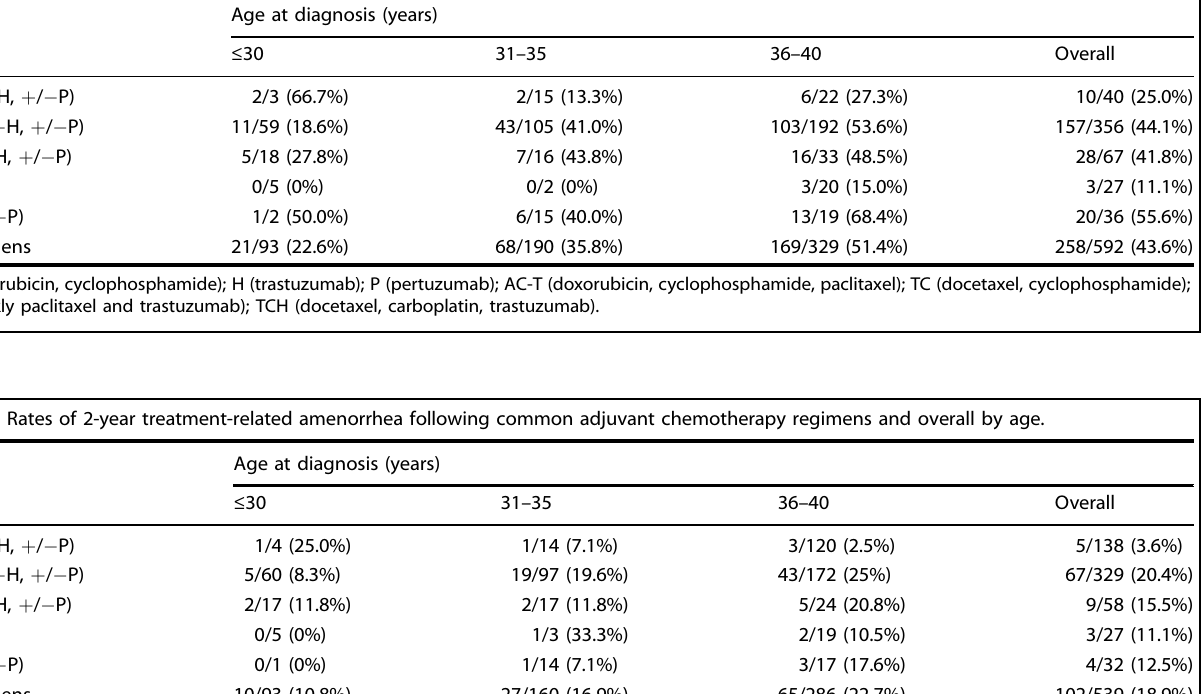
Table 3. Rates of 1-year treatment-related amenorrhea following common adjuvant chemotherapy regimens and overall by age. Regimen